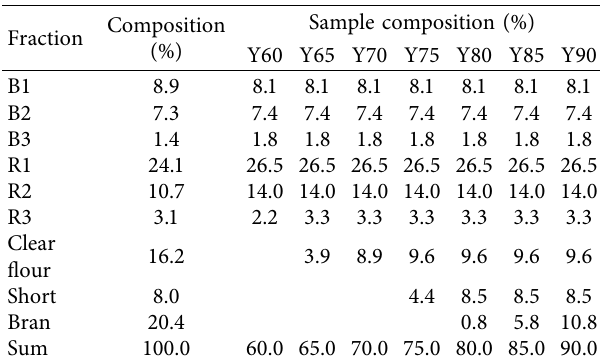
Clear flour Total 1 B1, B2, and B3 and R1, R2, and R3 are flours from three break rollers and three reduction rollers by Buhler laboratory mill, respectively. Table 2: Millstream composition (%) of the wheat flour samples that had 60–90%